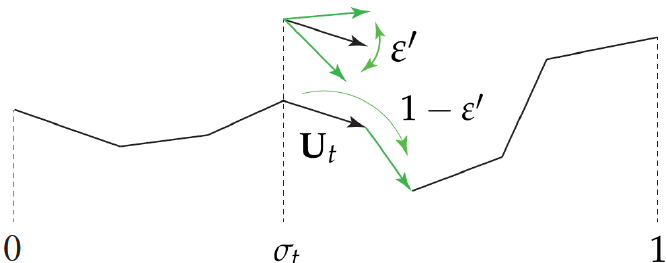
Figure 2. Tumbling-snake model. Strength of the orientational and one-dimensional diffusion of segment vector U t at relative position σ t along the polymer contour determined by ε (cid:48) ∈ [ 0,1 ] . The link-tension coefficient (cid:101) affects the stress